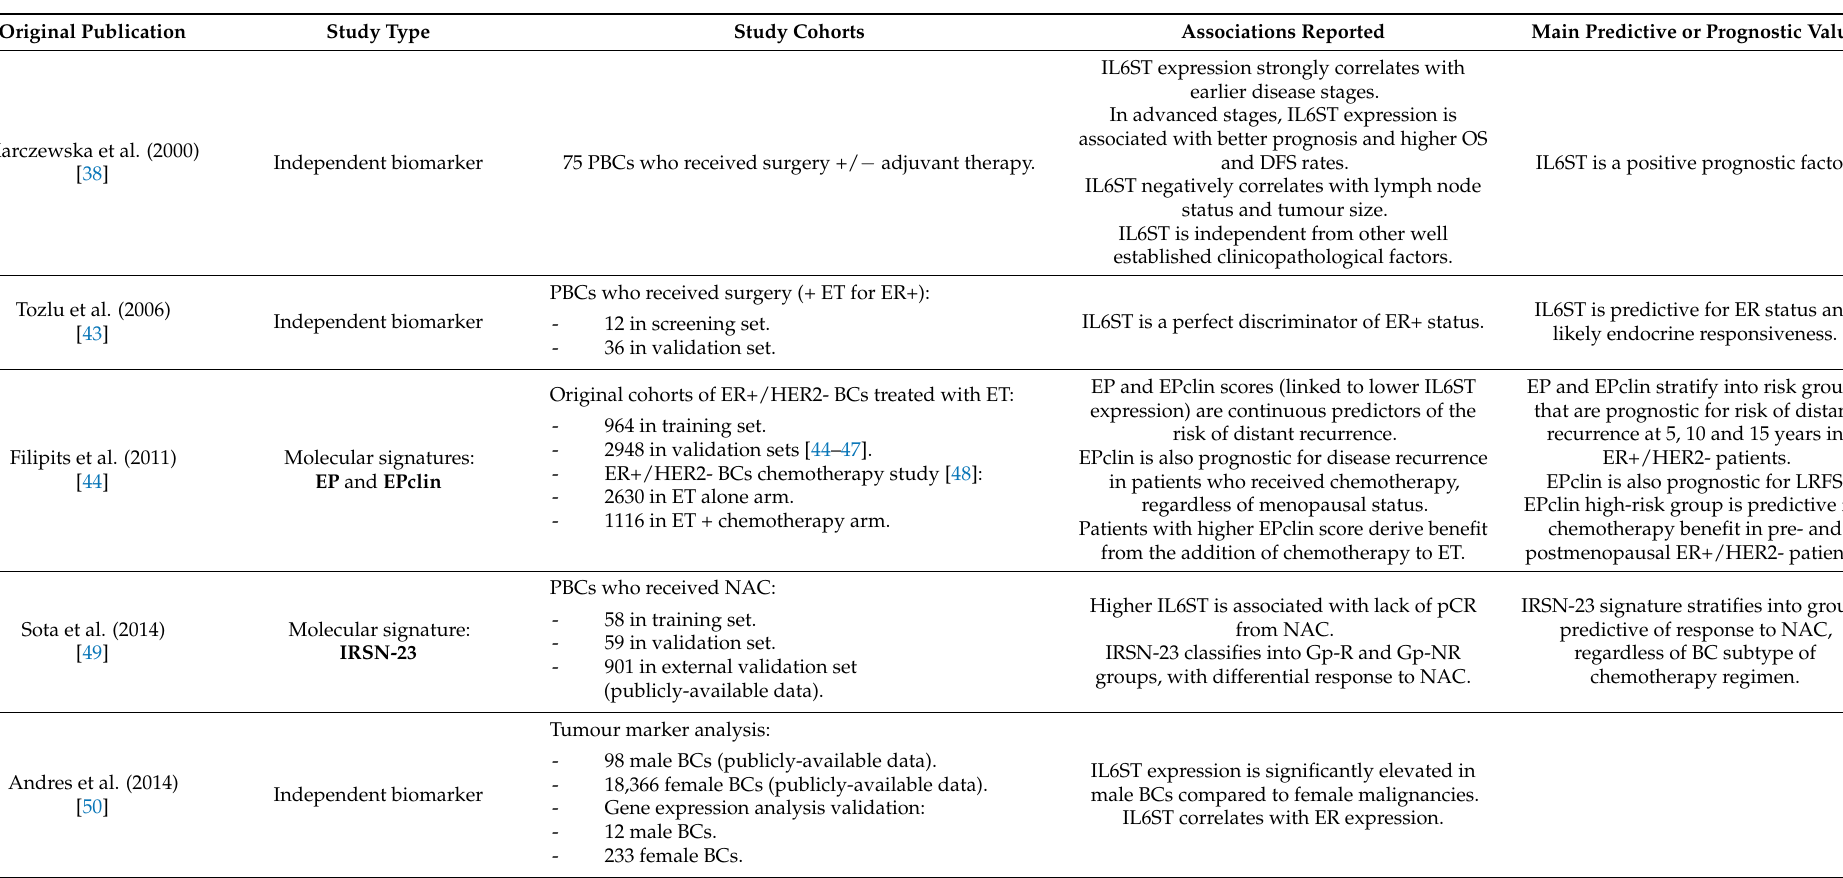
Table 1. Summary of studies reporting on the role of IL6ST as a biomarker in breast cancer, including study cohorts and main findings. Studies are listed in chronological order of the original publication. See Table 2 for further description of the multifactor signatures. All the described associations achieved statistical significance (at least p <